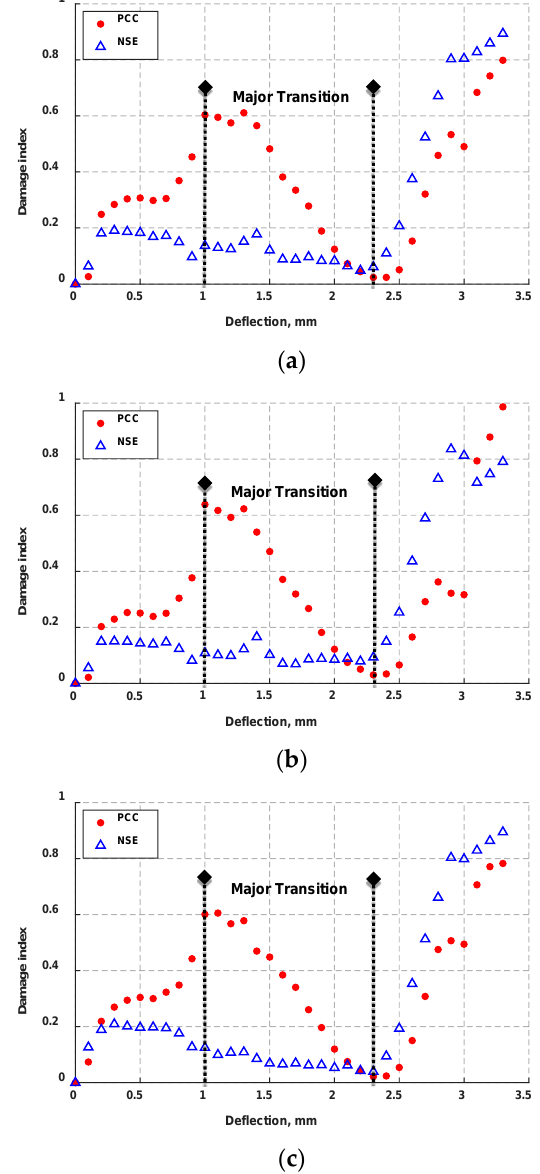
Figure 11. Damage index values based on Pearson correlation coefficient (PCC) and normalized signal energy (NSE) methods calculated for the first arrival of sensor signals received by: ( a ) d15 PZT-2; ( b ) d31 PZT-3; and ( c ) d15 PZT-1.